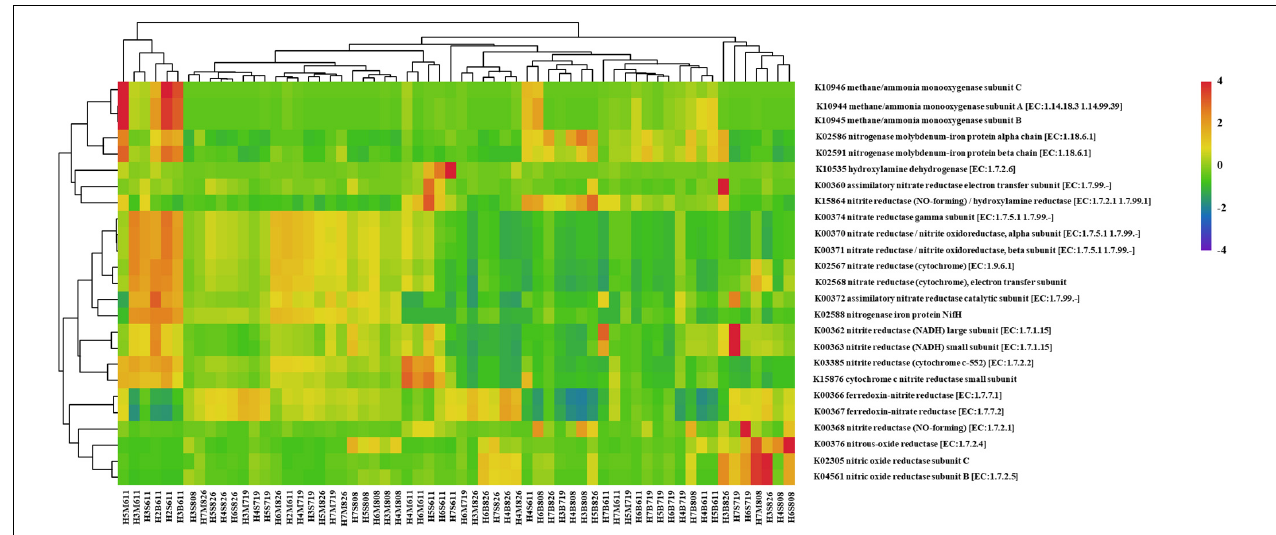
FIGURE 8 | Heatmap profile showing the nitrogen metabolism-related KO based on predicted gene copy in each sample (columns represent the 25 KEGG orthology (KO) functions, rows represent the samples, and the color intensity in the heatmap represents the abundance of the functional